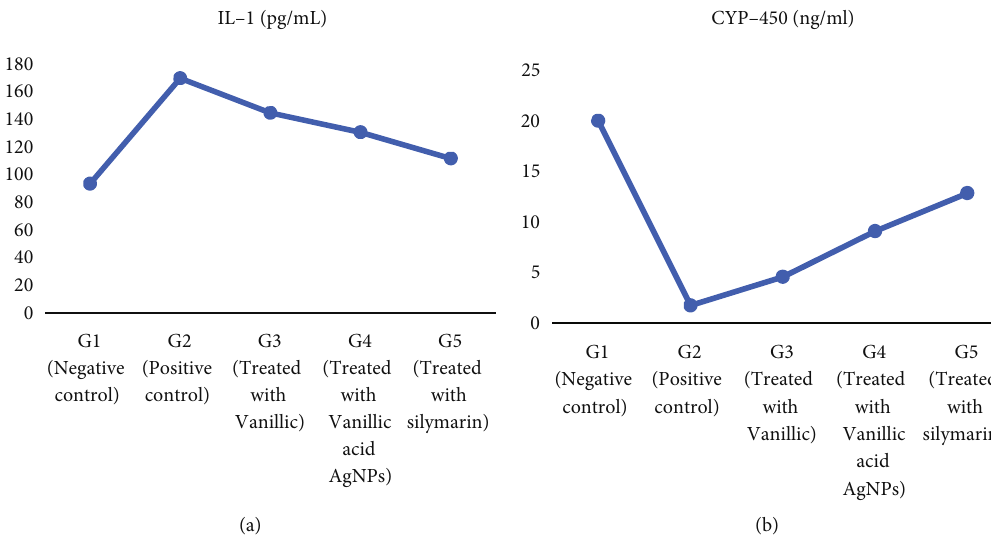
Figure 6: E ff ect of treating CCl -induced nephrotoxicity in male rats with vanillic acid, vanillic acid AgNPs, and silymarin on (a) serum IL-1 4 and (b) CYP-450